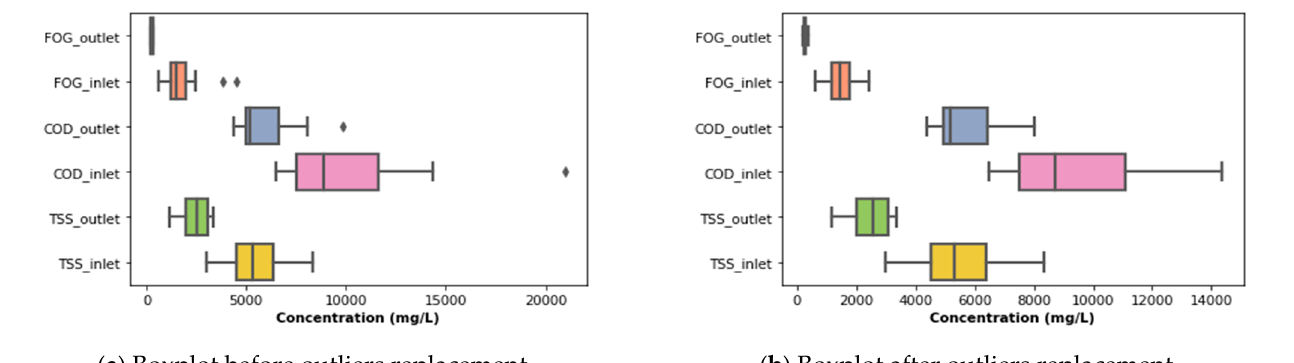
Figure 5. Boxplots of the investigated parameters during the pre-treatment stage.